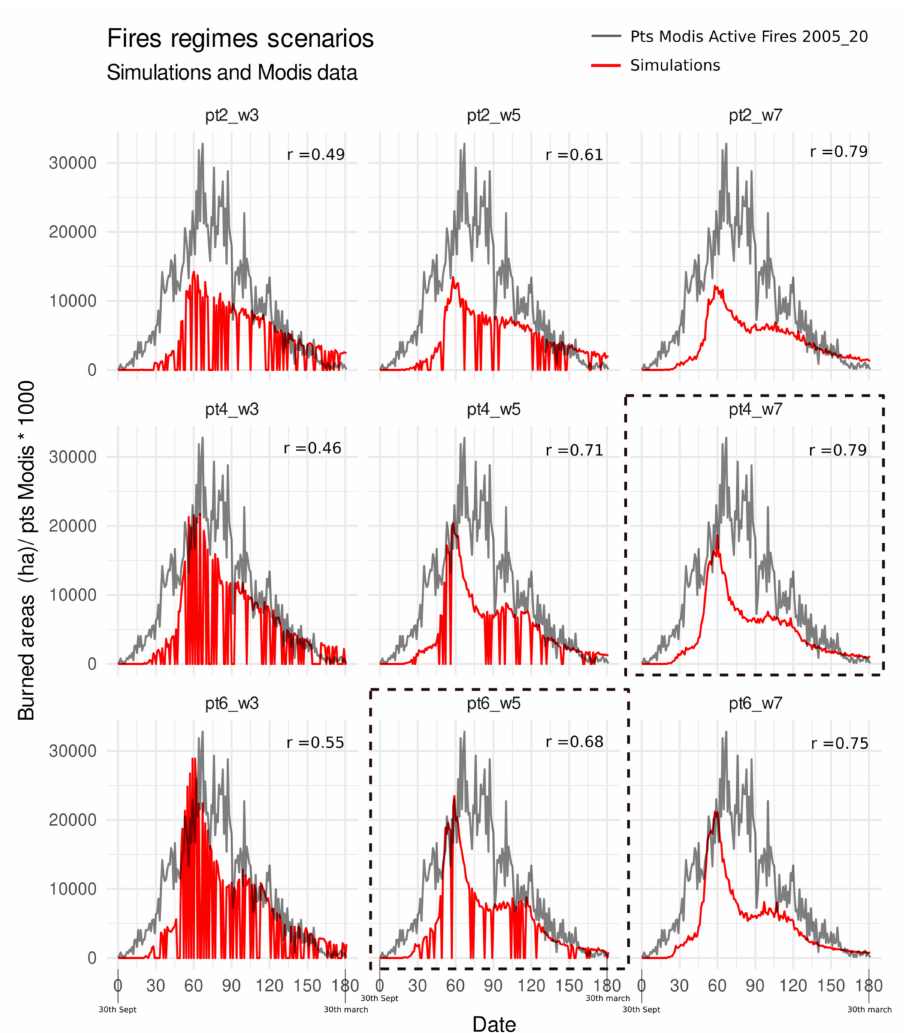
Figure 7. Simulations compared to MODIS active fires